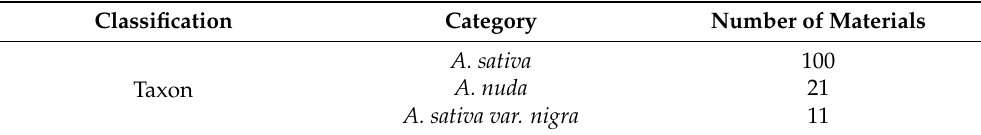
Table 1. Classification of the tested set of oat cultivars according to their taxonomy and their state of origin abbreviated as a three-digit